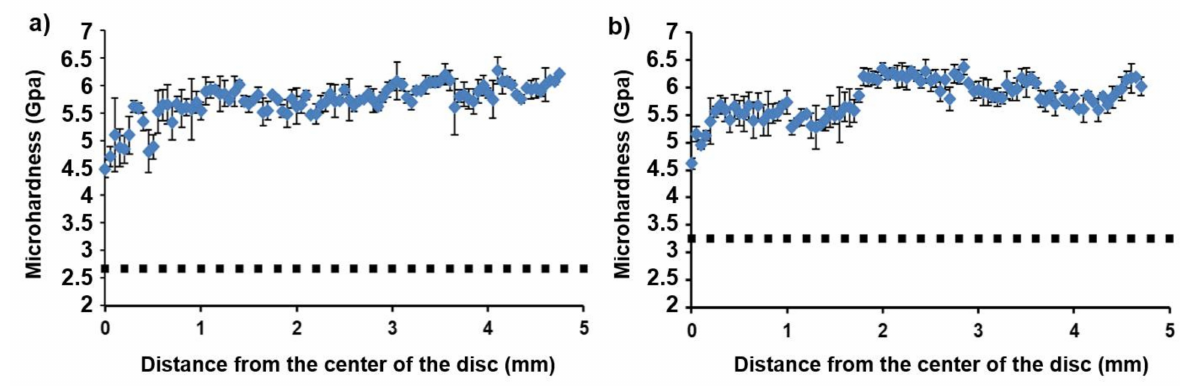
Figure 11. The dependence of the microhardness of the HPT-treated Ti–3wt.%Nb alloy pre-annealed at 450 ◦ C ( a ) and 600 ◦ C ( b ) on the distance from the disc centre. The dotted lines show the hardness in the initial